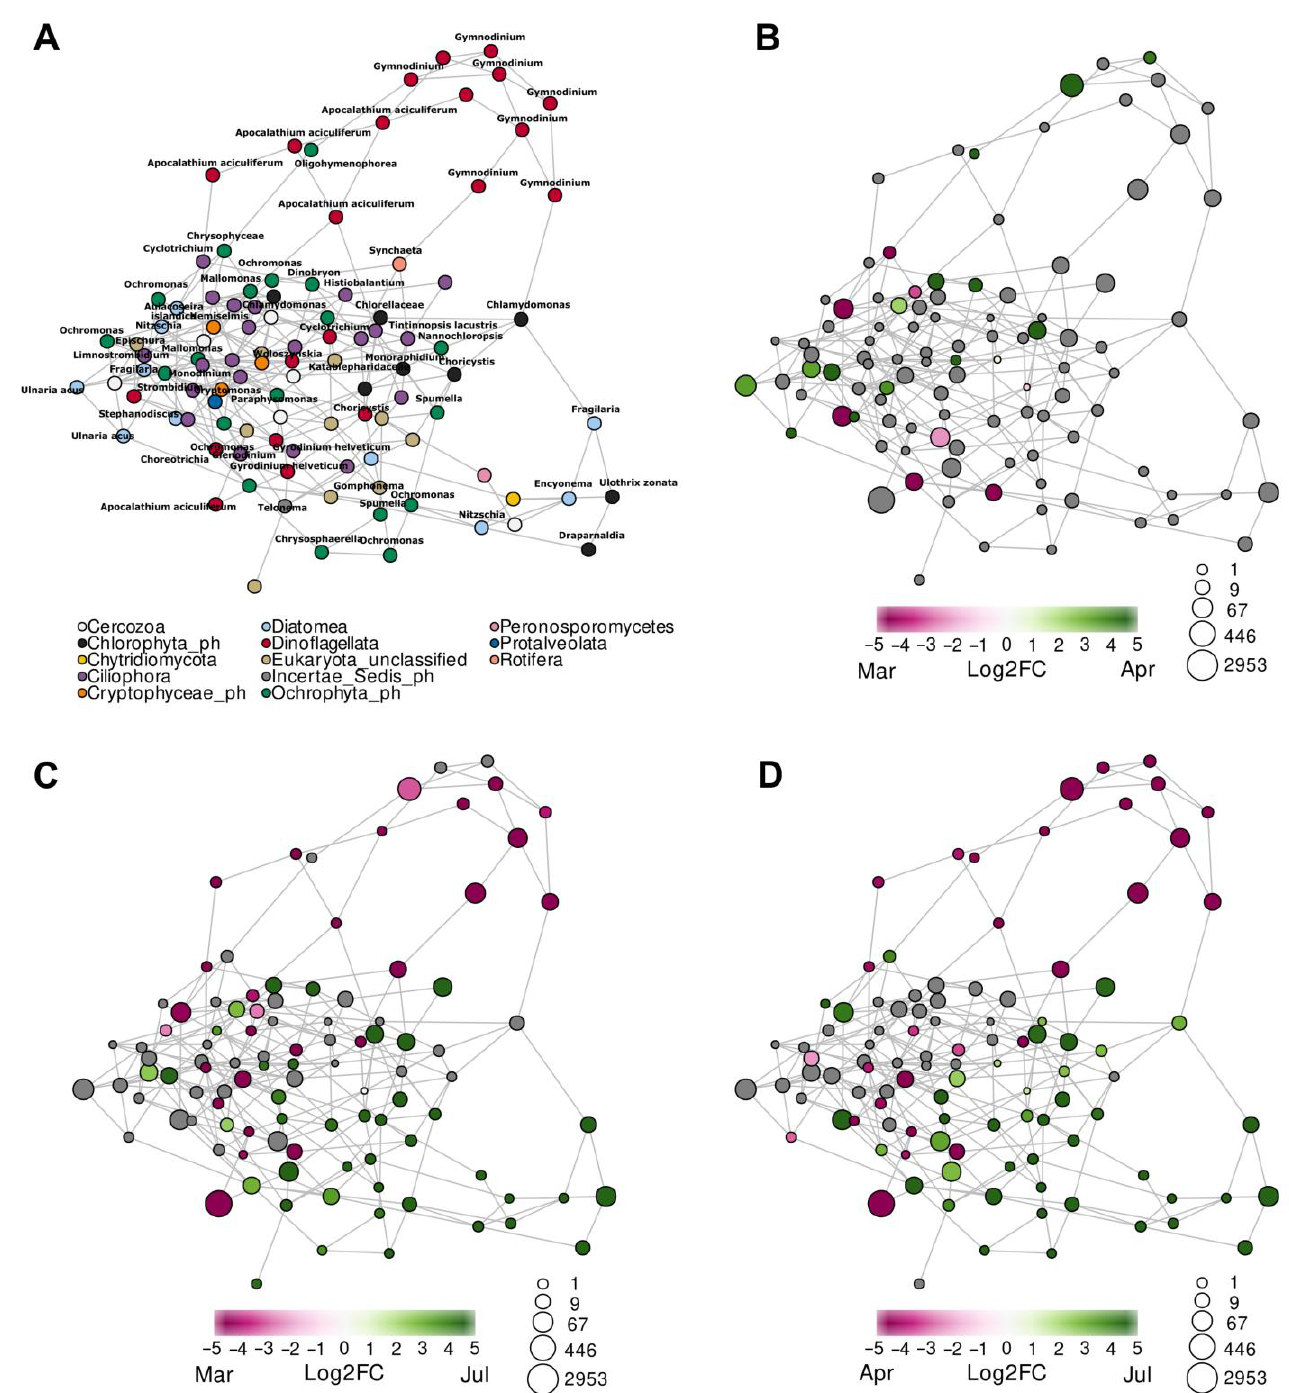
Figure 12. Co-occurrence networks of microeukaryotic communities. Graph layout colored by taxonomic assignment of OTUs at the phylum level ( A ); pairwise differential abundance of community profiles by month of sampling: March vs. April ( B ); March vs. July ( C ); April vs. July ( D ). The graph layout is preserved. The size of vertex in DA-graphs is proportional to mean OTU abundance.